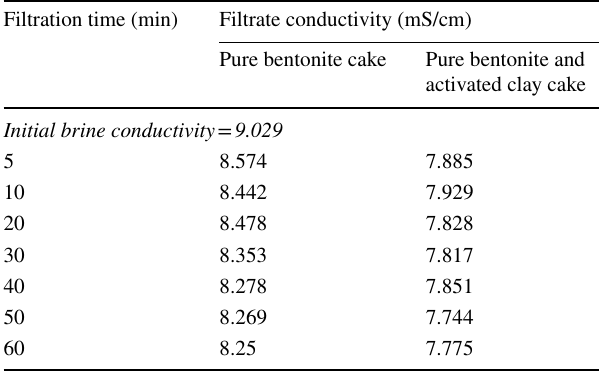
Table 4 Total dissolved solids (TDS) (measured in terms of conduc- tivity) of the filtrate from the filter cake of pure bentonite and blend of pure bentonite and activated